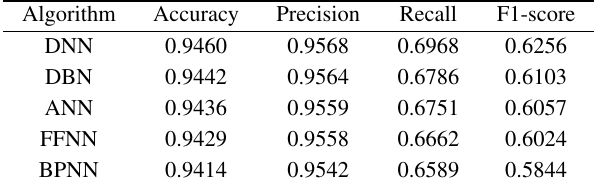
Table 3 Performance of lopinavir drug interaction with SARS-CoV-2 virus over Indian datasets.